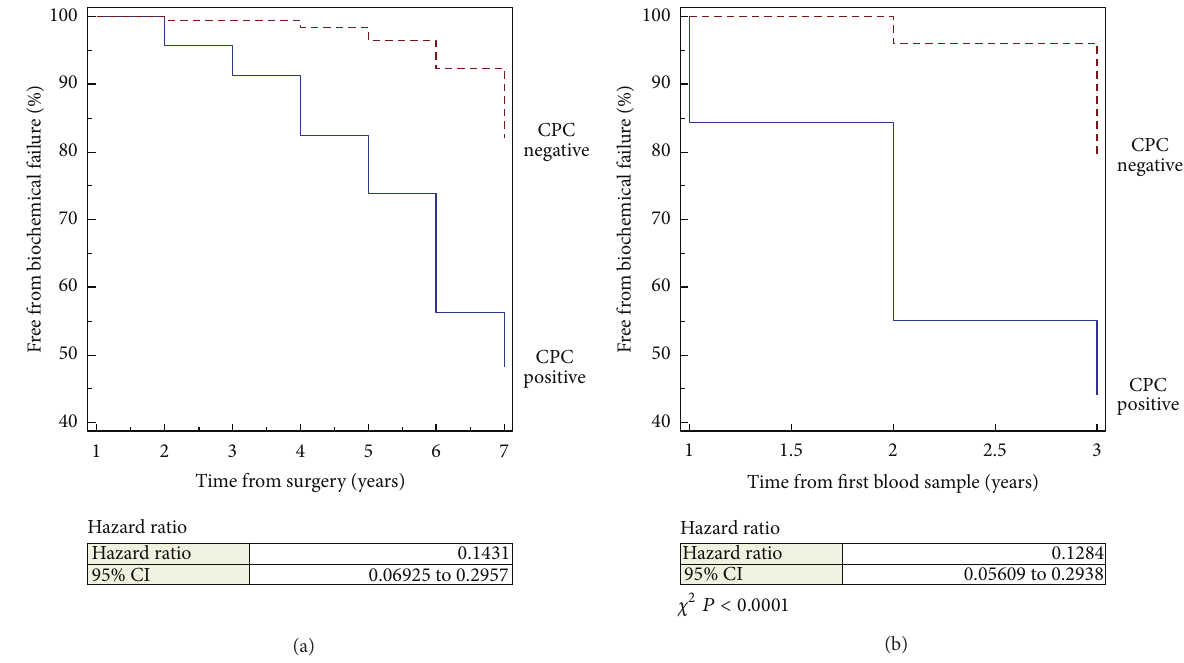
Figure 2: Kaplan-Meier plot time free of biochemical failure from time of (a) surgery and (b) blood sampling.